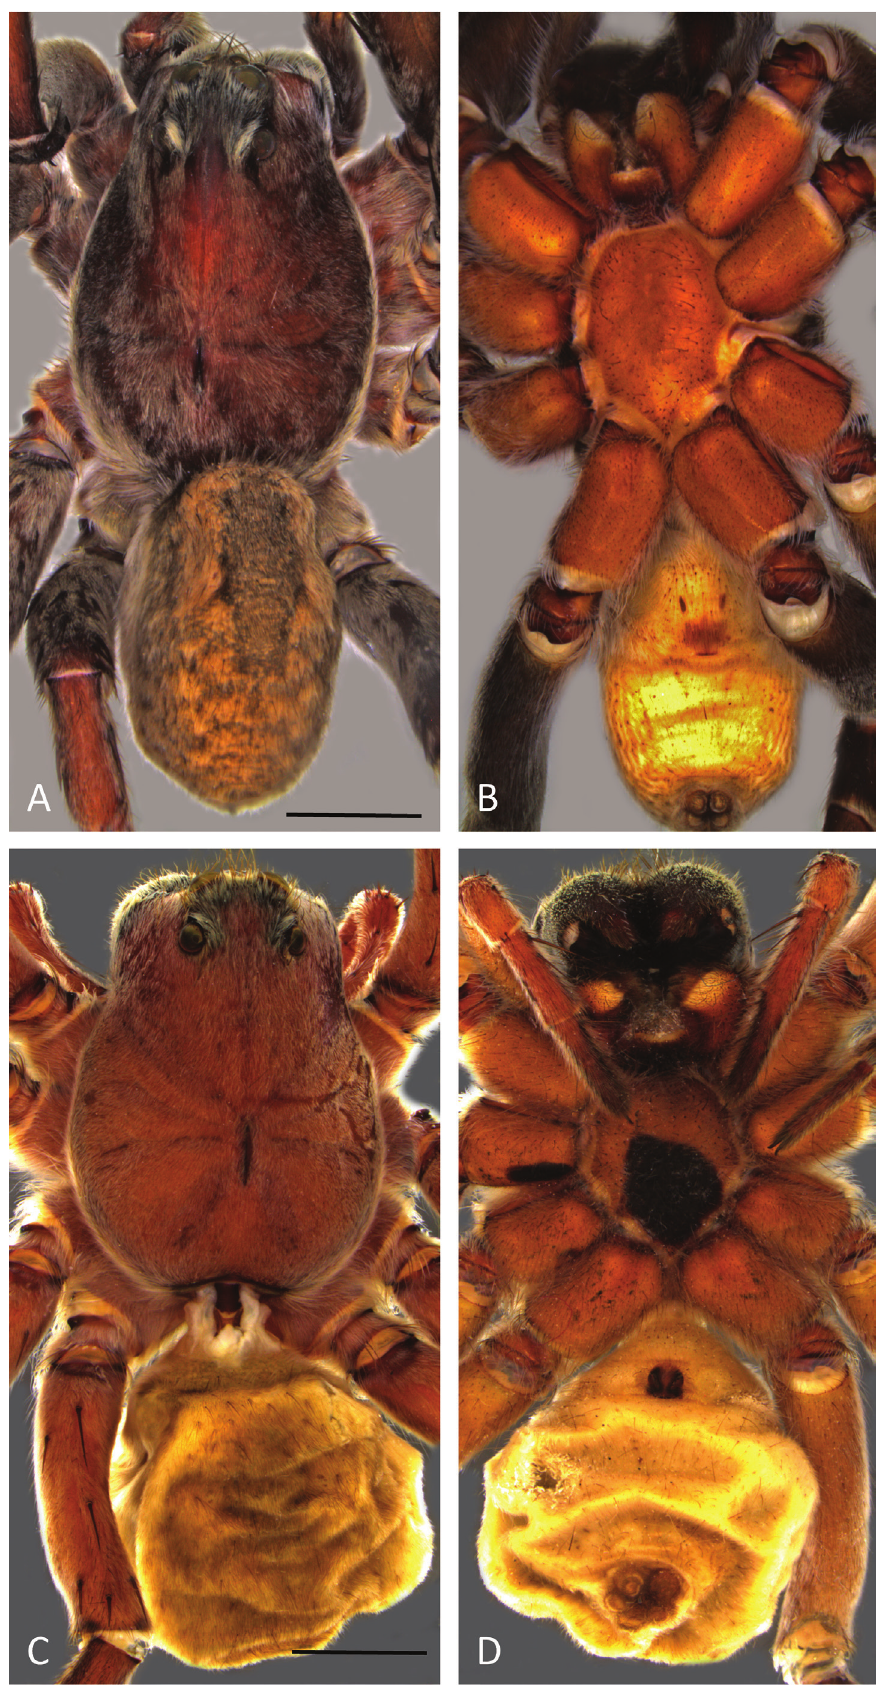
Figure 2. Portacosa cinerea gen. n. and sp. n., male holotype (WAM T68032) and female paratype (WAM T53550). A, B, male ho- lotype in dorsal ( A ) and ventral ( B ) view. C, D, female paratype in dorsal ( C ) and ventral ( D ) view. Scale bar: A, B – 2.5; C, D –